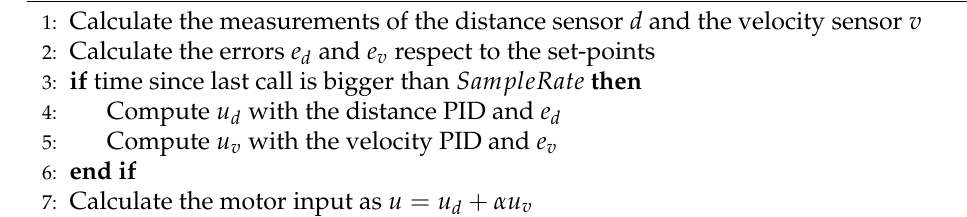
Algorithm 3 Control routine for following